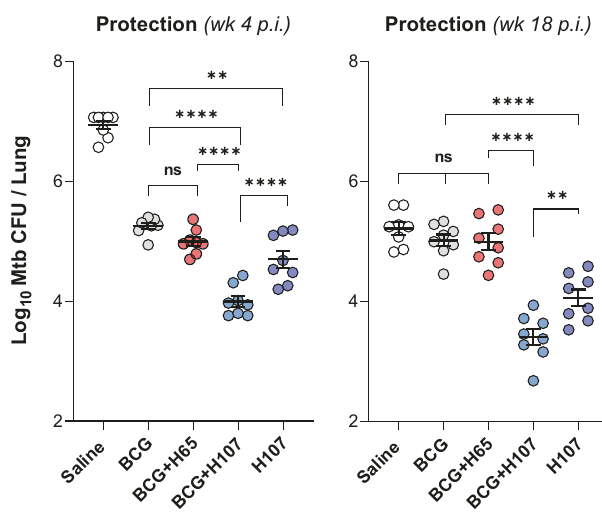
Fig. 6 H107 and BCG co-administration induces synergistic protection. CB6F1 mice were immunized once s.c. with BCG, three times s.c. with saline or 1 µ g H107/CAF ® 01, or co-administered BCG with H65/CAF ® 01 or H107/ CAF ® 01 followed by two subunit boosts( n = 8). The bacterial burden was determined in the lungs 4 and 18 weeks postinfection (p.i.). Symbols indicate individual mice with lines indicating mean ± SEM. One-Way ANOVA with Tukey ’ s multiple comparisons test. p values; ** p < 0.01 (wk4 p = 0.0012, wk18 p = 0.0056), **** p < 0.0001, and ns (nonsigni fi